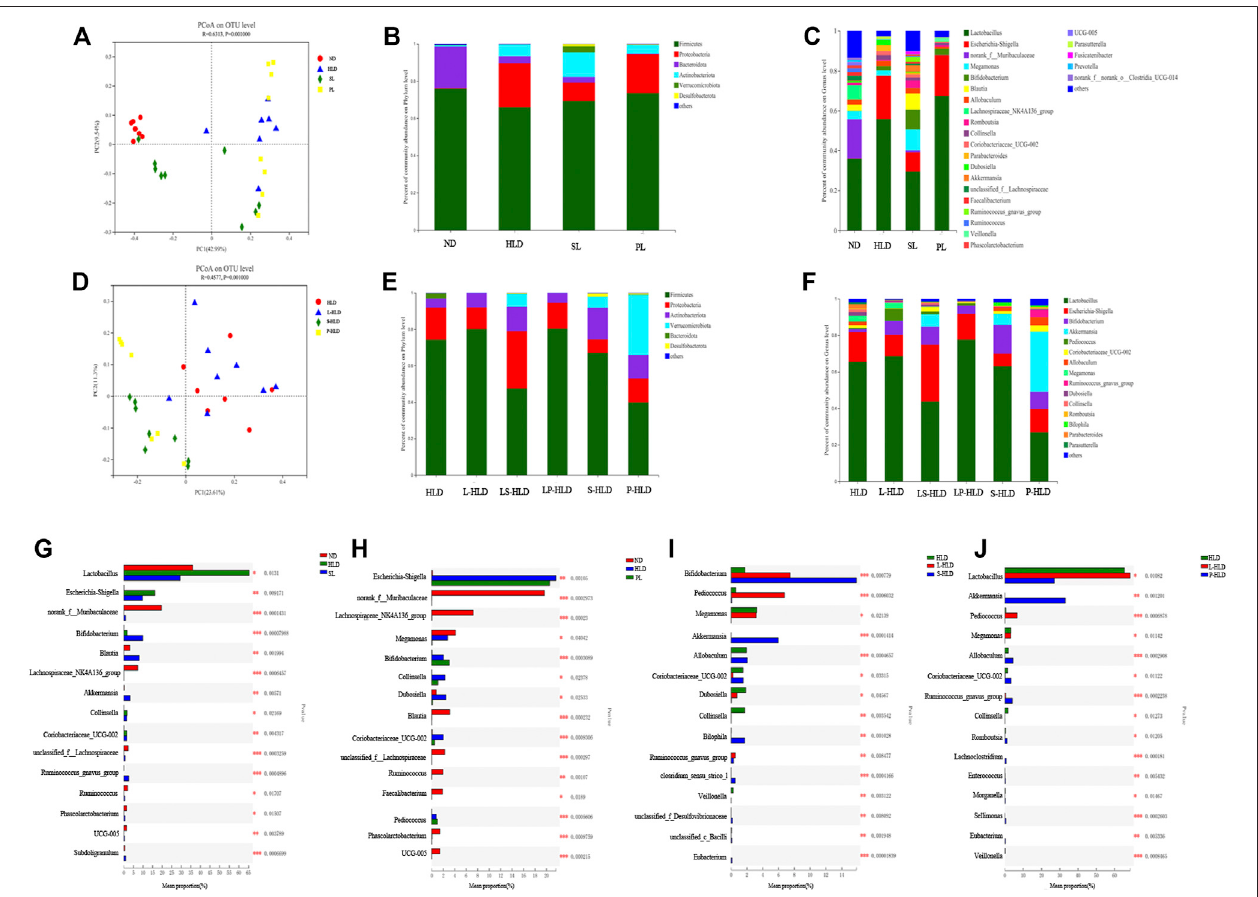
FIGURE4| Effectsofdifferenttreatmentsonluminalbacterialcommunitystructure.UniFrac-basedPCoAofthecolonicbacterialcommunityattheOTUlevelunder SL (A) , PL (A) and CMT treatment (D) . Relative abundance of luminal bacteria at the phylum level (B,E) and genus level (C,F) among distinct groups. Comparison of dominant genera under different treatments (G – J)